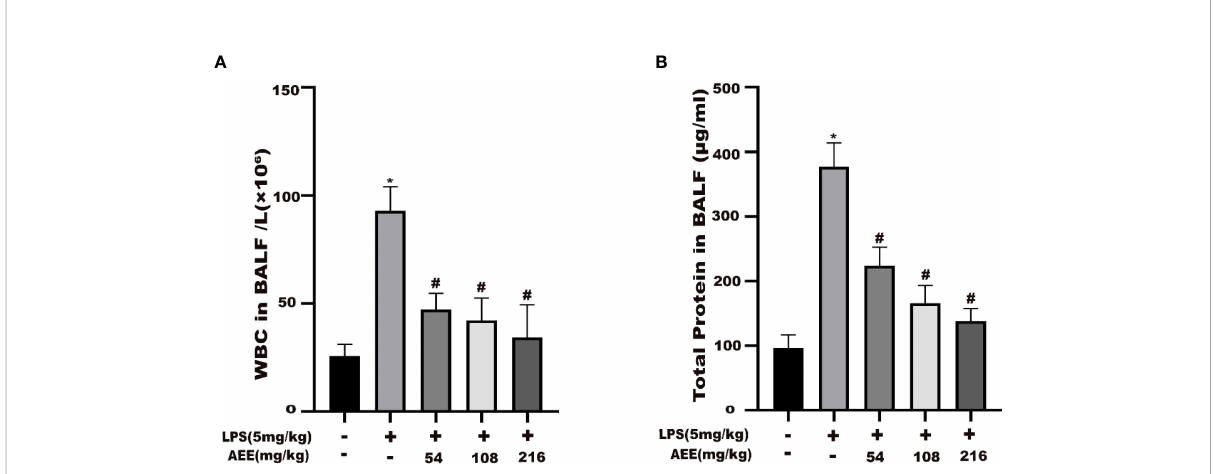
FIGURE 3 Effect of AEE on the number of WBC in BALF and total protein level in BALF of LPS-induced ALI rats. (A) WBC in BALF, (B) Total protein in BALF. Values are presented as the means ± SD where applicable ( n = 8). * P < 0.05 compared to control group, # P < 0.05 compared to LPS